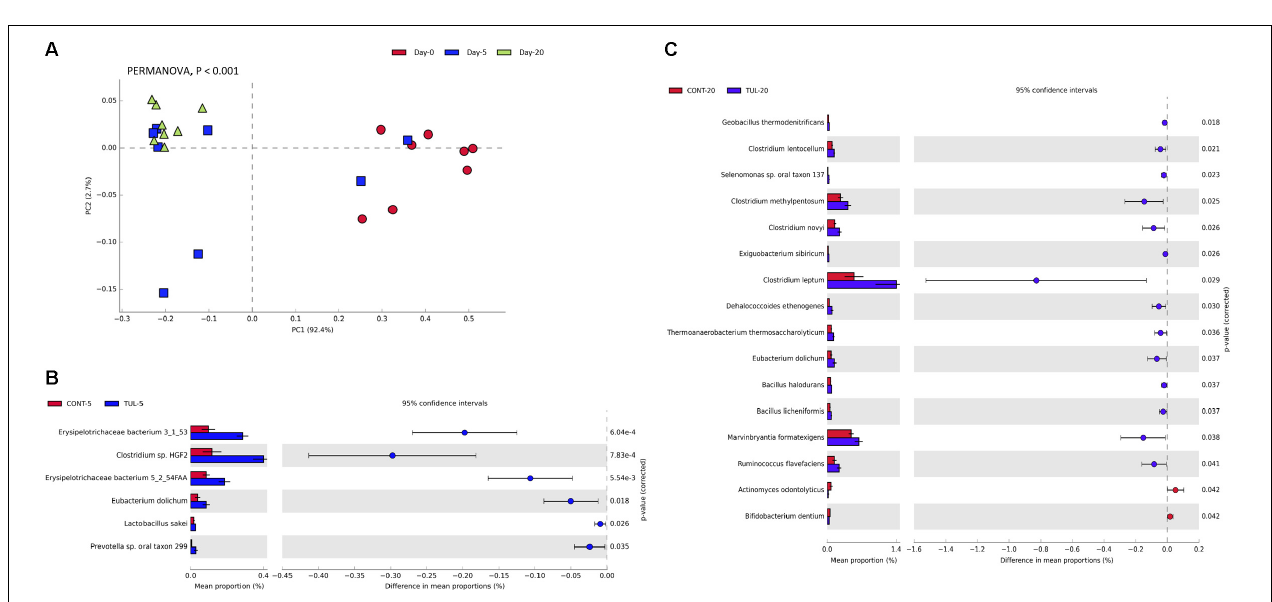
FIGURE 1 | Taxonomic classification of shotgun metagenomic sequences at the phylum level for the control (CONT) and tulathromycin (TUL) treated piglets at each sampling time days (0, 5, and 20). Only those bacterial phyla that averaged more than 1% of the relative abundance across all samples are displayed.